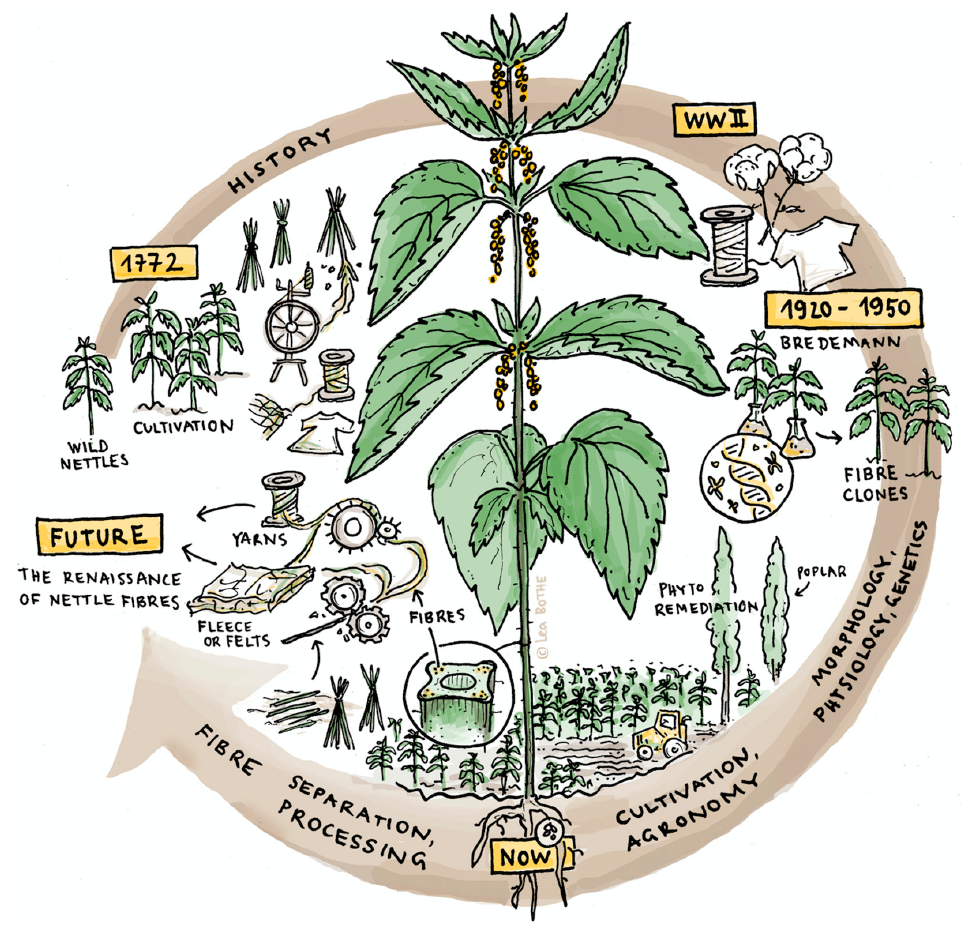
Figure 1. Graphical representation of historical advances in the development of nettle.